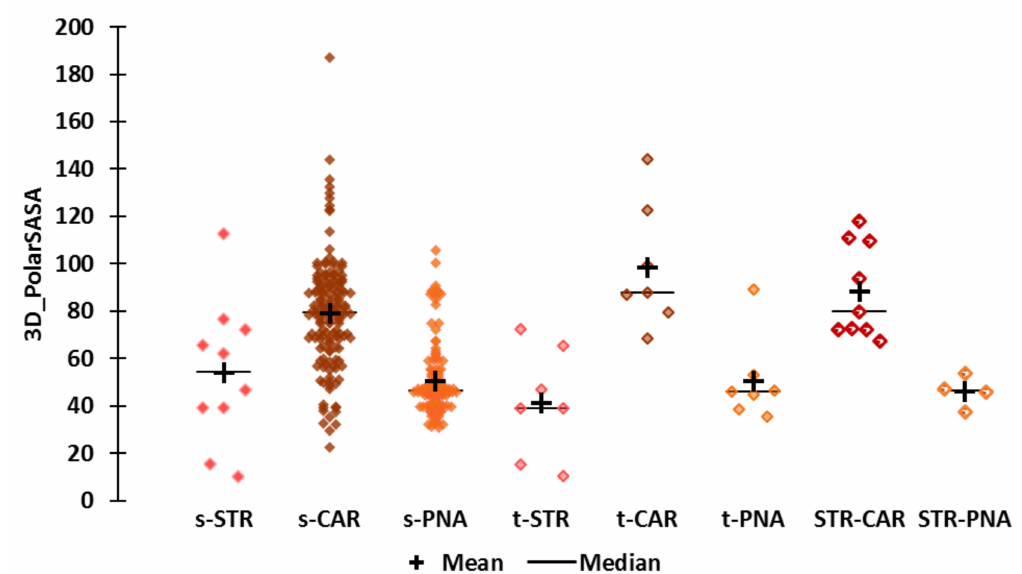
Figure 6. Scattergrams of the 3D_PolarSASA values by odor